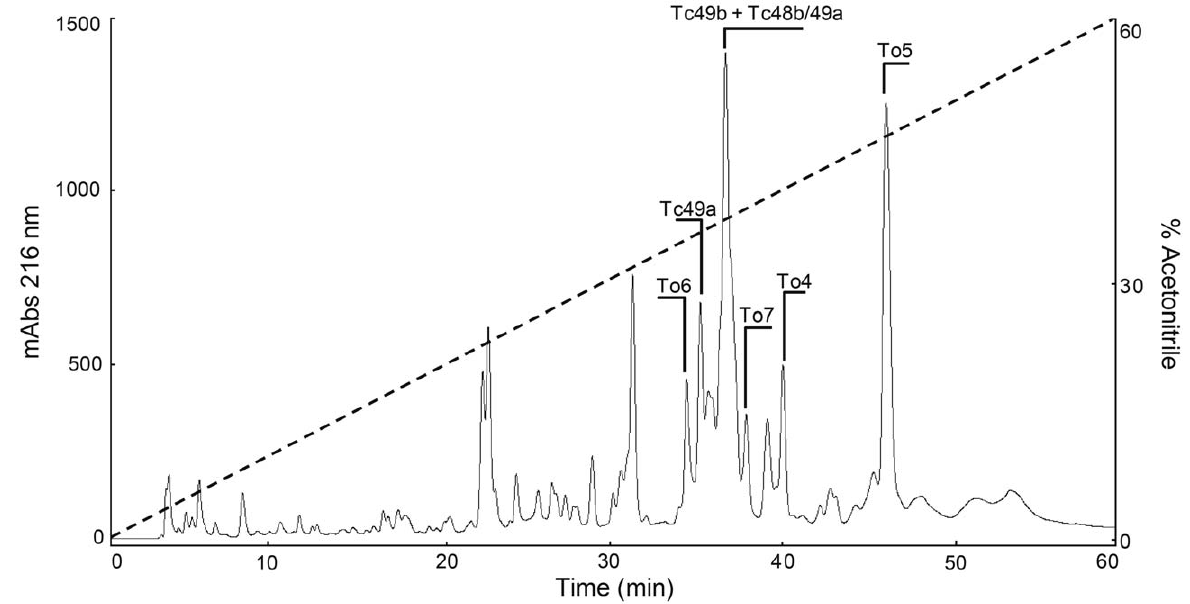
Figure 3. High performance liquid chromatography separation of 1.0 mg soluble venom from T.obscurus . This was performed in an analytical C18 reversed phase column equilibrated with solution A (water in 0.1% TFA), using a gradient from 0 to 60% solution B (acetonitrile in 0.12% TFA) over 60 min, with a flow rate of 1 mL/min and absorbance at 216 nm. Fractions labeled in the chromatogram (Tc49b to To7) were detected at both protein and transcript levels.